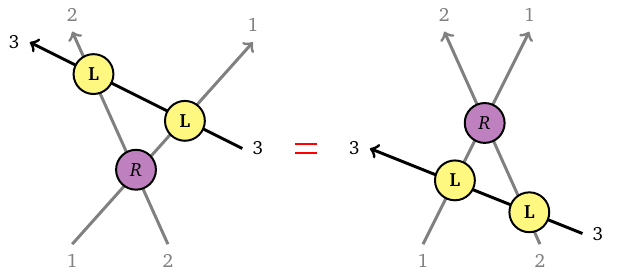
Figure 1: Graphical representation of the Yang–Baxter relation (8). From the particle scat- tering perspective, the relation imposes the equivalence of two apriori district ways of three consecutive pairwise elastic scatterings. Time direction for physical particles flows vertically and is shown by gray trajectories. The R -matrix R ( z permutation on two fundamental physical particles in a su ( n | m ) symmetric integrable